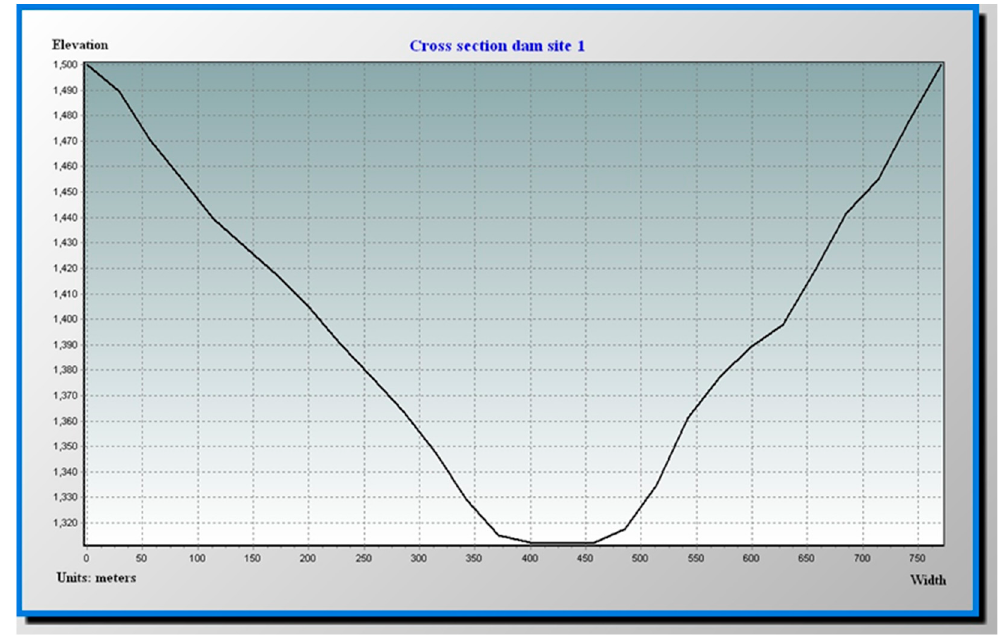
Figure 12. Evaluation parameters for Dam site 1: ( a ) catchment area ( b ) elevation ( c ) triangulated irregular network (TIN) ( d ) slope ( e ) contours ( f ) LULC ( g ) 3D view.